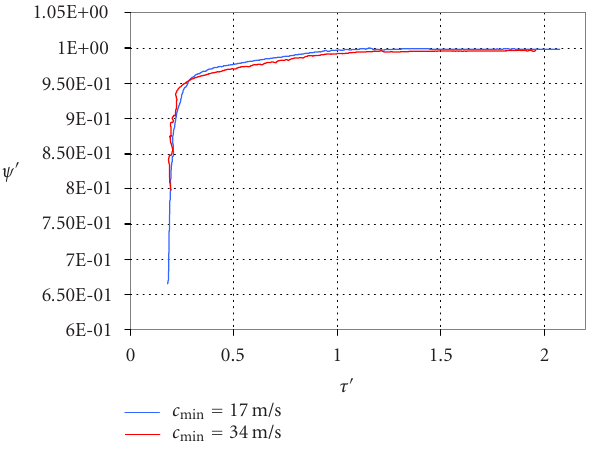
Figure 12: Comparison between numerical simulation and experi- mental measurements. The nondimensional inducer axial length z (cid:1) is given in abscissa. (The reference z (cid:1) = 0 is the leading edge posi- tion near the hub.) τ (cid:1) , corresponding to the apparition of vapor in the plane z (cid:1) = constant, is reported in